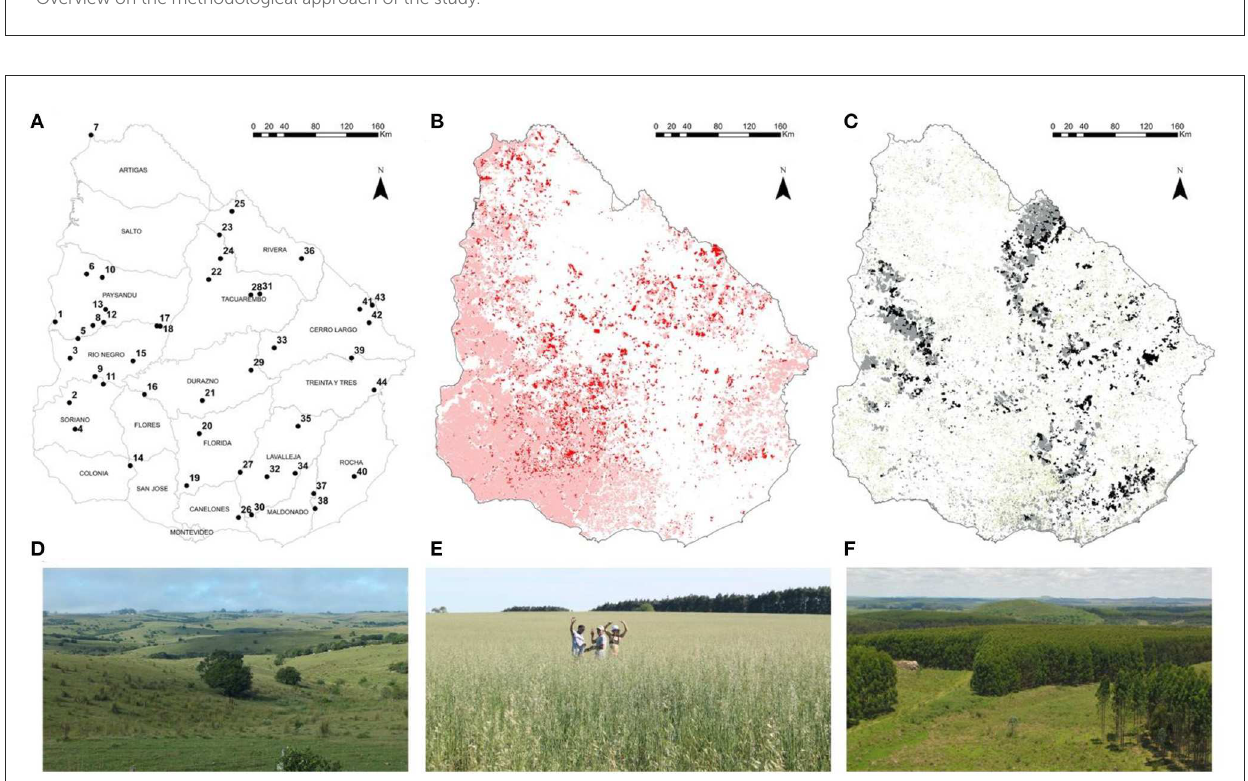
FIGURE3 Location of 44 monitoring sites across rural Uruguay (A) . The current land-use change in Uruguay consists of expansion of agricultural monocultures [ (B) ; rose: 2000; red: 2011] and afforestation of originally extensively used grasslands (C) with large Eucalyptus plantations ( > 5ha, gray: 2000; black: 2011, olive colored areas show small scale Eucalyptus plantations ( < 5ha established for shelter and shading livestock). The data for the maps are from the Uruguayan geoservice agency (MA, 2022). The photographs provide impressions from natural grasslands near Las Cañas, Cerro Largo (D)